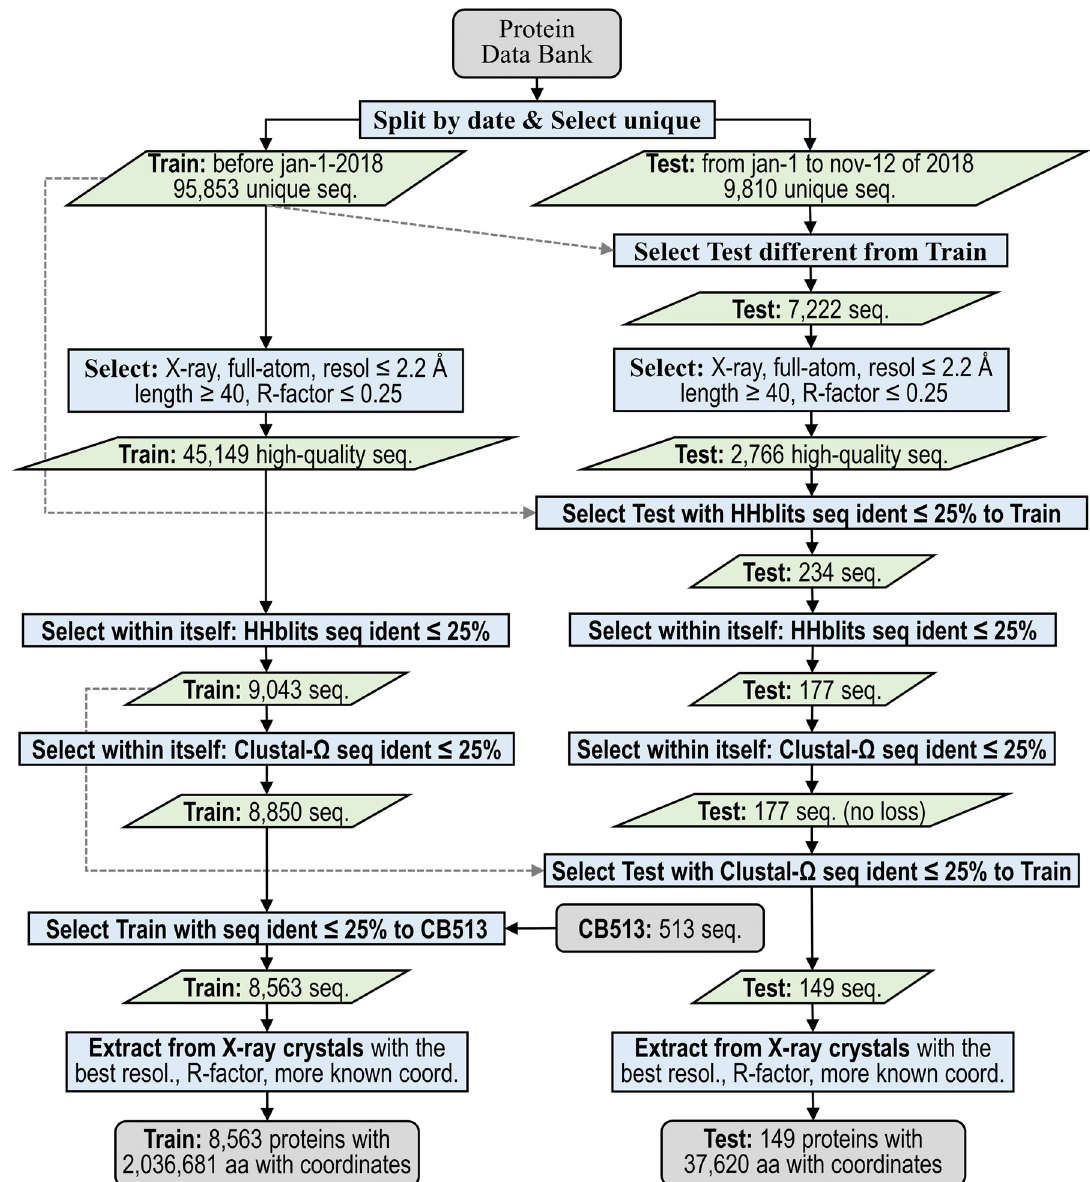
Fig 1. Protocol flowchart for preparation of 2018 unbiased test and training sets ( Set2018 dataset). Protocol input and output are shown with gray rounded rectangles. All action processes are in blue rectangles. Green parallelograms represent intermediate input and output data. The split date for Set2018 training and test sets is Jan 1, 2018. By using two sequence alignment programs, the protocol removes from the test set any proteins with more than 25% sequence identity to any previously published PDB structure of any experimental type, resolution, or quality. The test set guarantees unbiased accuracy estimation for our prediction method, SecNet , and any previous software trained and validated on proteins released before Jan 1, 2018. For the training/validation set, the same resolution, R-factor, length, and sequence identity criteria were applied to the sequences and structures that were released by the PDB prior to 2018. Chains with sequence identity � 25% with any protein in the popular CB513 data set were also removed from the set so that CB513 could also be used in testing (see below). The resulting set was split with a 9:1 ratio to produce the training and validation sets. We applied